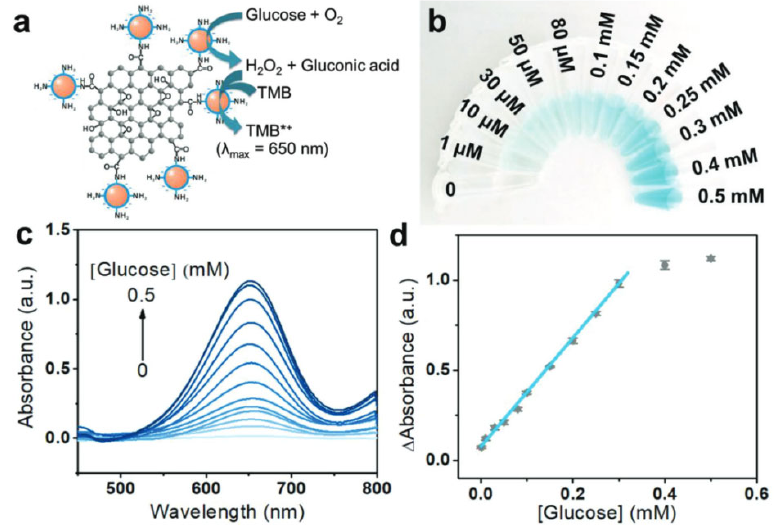
Figure 16. Colorimetric glucose determination by a BSA–Au/graphene oxide composite. ( a ) Working principle of the nanozymatic system that accomplishes TMB oxidation to TMB* + ; ( b ) Reaction solutions of different glucose concentration stocks; ( c ) Resulting UV ‐ vis spectra; and ( d ) Linear correlation between absorbance and [Glucose]. Reprinted with permission from [63]. Copyright © 2018 Wiley.